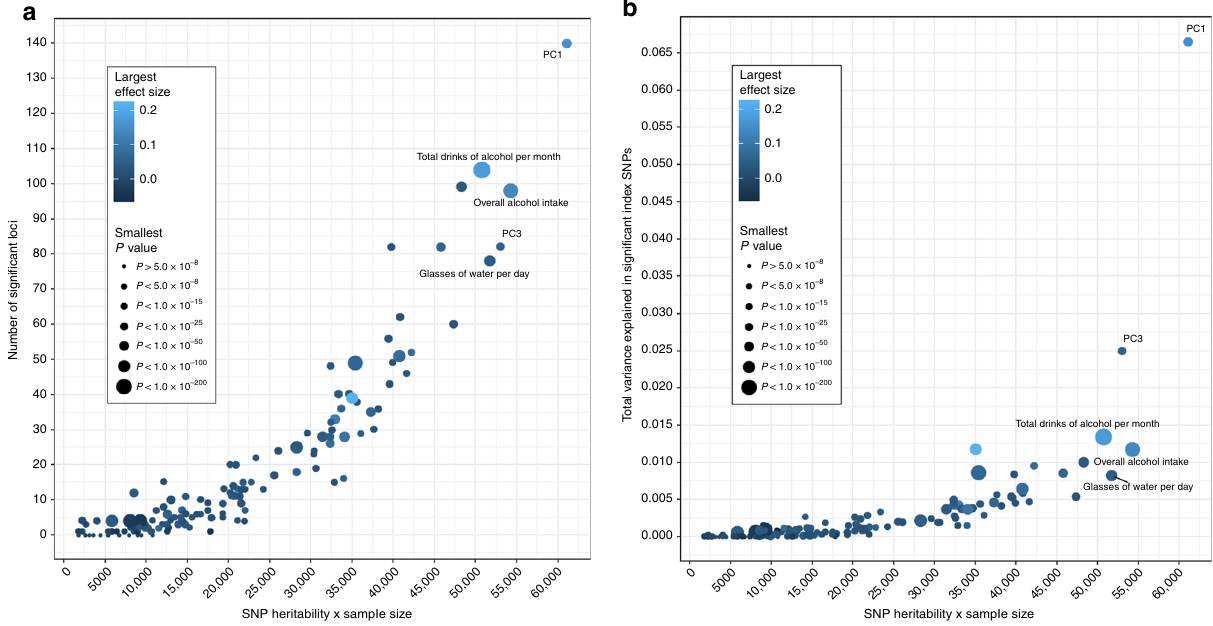
Fig. 2 Relationship between SNP heritability and GWAS success. a Scatter plots of the number of genome-wide signi fi cant loci or b variance explained by genome-wide signi fi cant SNPs vs. SNP heritability × sample size for all 143 signi fi cantly heritable traits. Points are colored by the largest effect size and sized by the smallest P value of their signi fi cant index